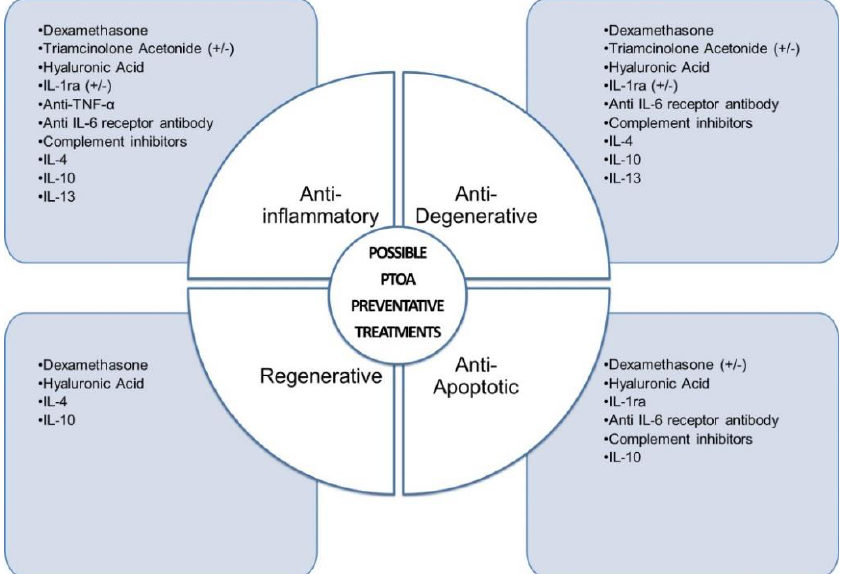
Figure 3. Possible treatment interventions that could prevent or delay PTOA-driving processes in the knee joint by suppressing inflammation, degeneration and apoptosis, while activating regenerative processes. All of the therapeutic candidates shown here exert anti-inflammatory effects by decreasing the injury/inflammation-related joint swelling, synovial inflammation and/or levels of pro-inflammatory mediators. Although some agents have anti-degenerative activity, and inhibit cartilage degradation following injury by, e.g., decreasing the expression of MMPs as well as the loss of GAG, anti-TNF- α showed adverse effects on cartilage and bone and increased inflammation. Few of these agents have regenerative effects that are capable of enhancing the chondrogenic properties of injured cartilage. Similarly, only a few agents counteract the apoptosis of chondrocytes. Only hyaluronic acid and IL-10 possess all four main therapeutic potentials against PTOA development. The (+/ − ) sign indicates conflicting reports, based on knee joint-related clinical, articular cartilage ex vivo and/or in vitro